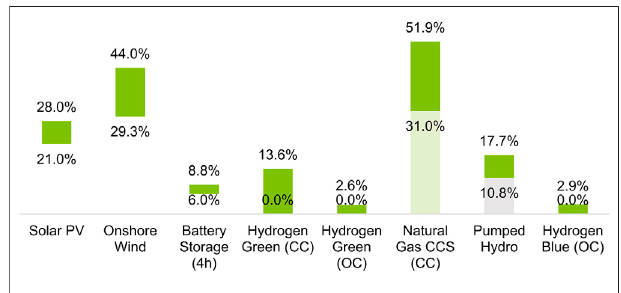
FIGURE 6 | Minimum and maximum capacity factors of power generation and storage technologies for all